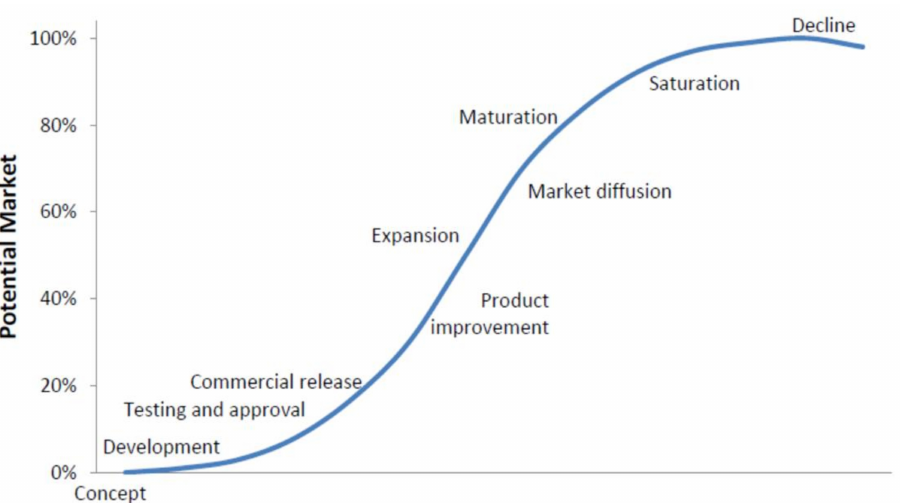
Figure 3. Predictable distribution pattern of innovations often called S-curve according to Rogers’ law